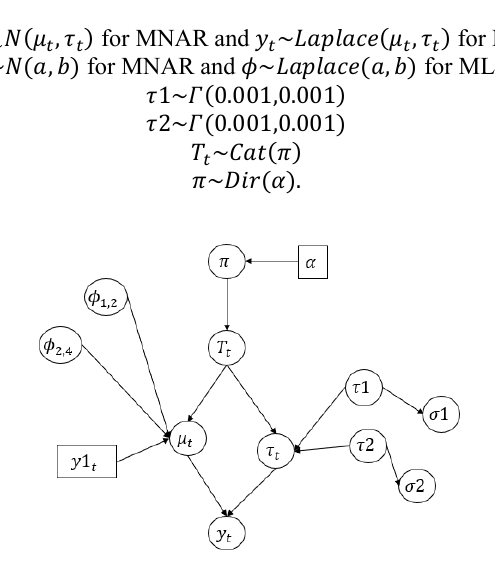
Fig. 4 The DAG of Mixture Autoregressive Models (example: MLAR (2;[2],[4])